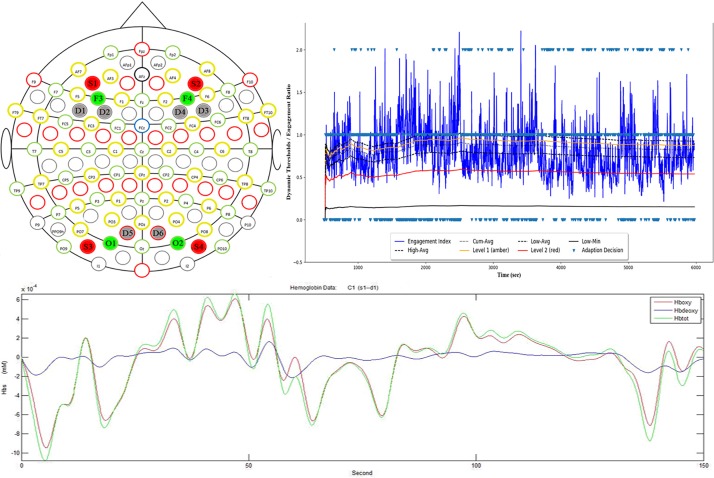
(Upper Right) EEG electrode and fNIRs optode placement; (Upper Left) real-time BCI input showing, engagement index values and adaptive thresholds; (Bottom) example fNIRs signal acquired from Source 1 Detector 1 Frontal Region.